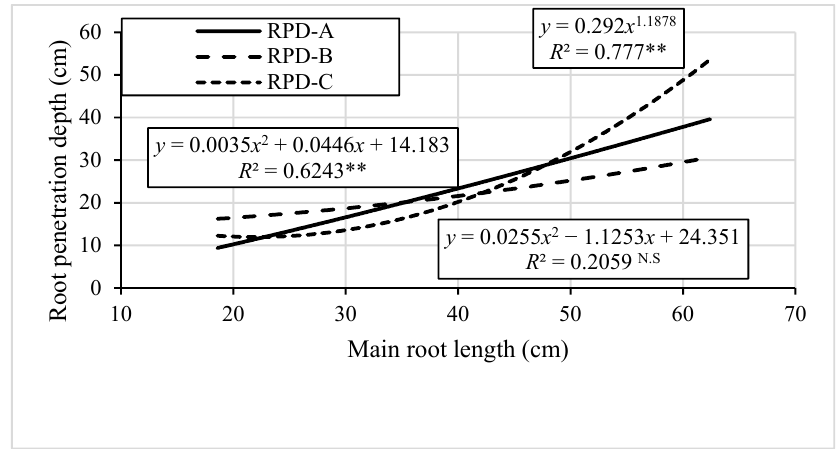
Figure 9. Relationship between main root length and root penetration depth of maple seedlings in three areas (RPD: root penetration depth; A: control area; B: Log skidded area; C: Tire track area).